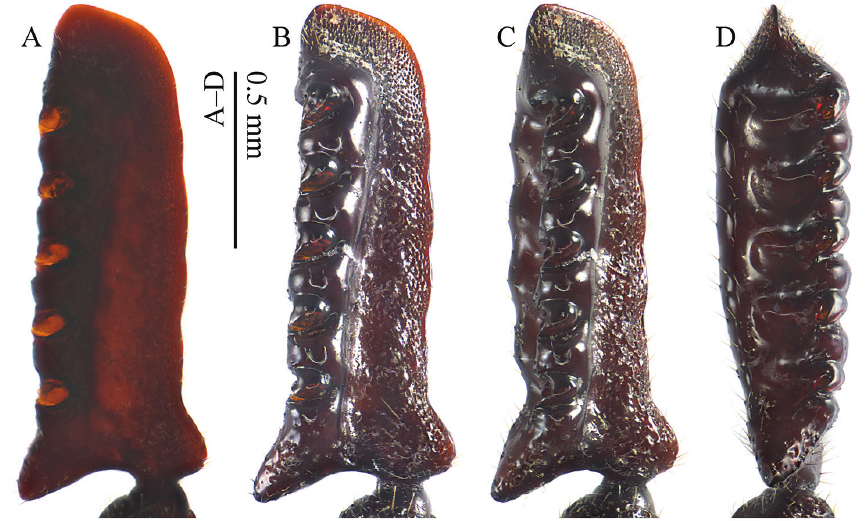
Figure 4. Antenna of Paussus ( Scaphipaussus ) zhouchaoi sp. n. (holotype, ♂ ). A dorsal view, in ethanol solution B dorsal view C dorsoposterior view D posterior